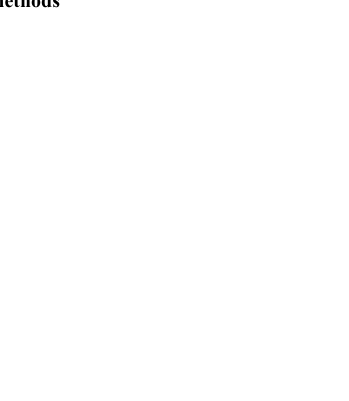
Figure 7. Feet distribution by the different